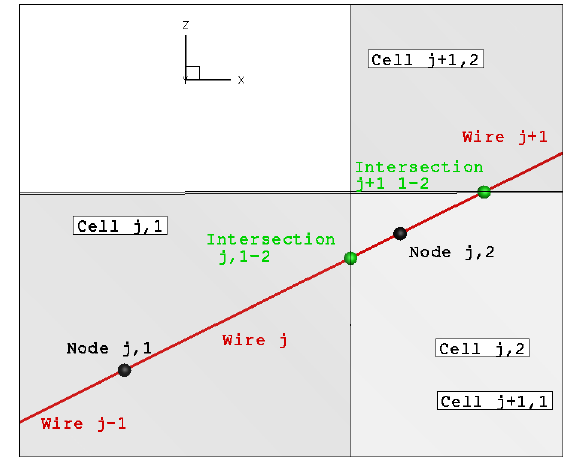
mation orders are chosen from 2 to 5. Actually, empty spaces between walls are meshed with few cells and associated to a high order approximation. By contrast, exterior walls, made with concrete, are represented by cells with small size and solved with a lower order. Interior walls are modeled by metallic surfaces.